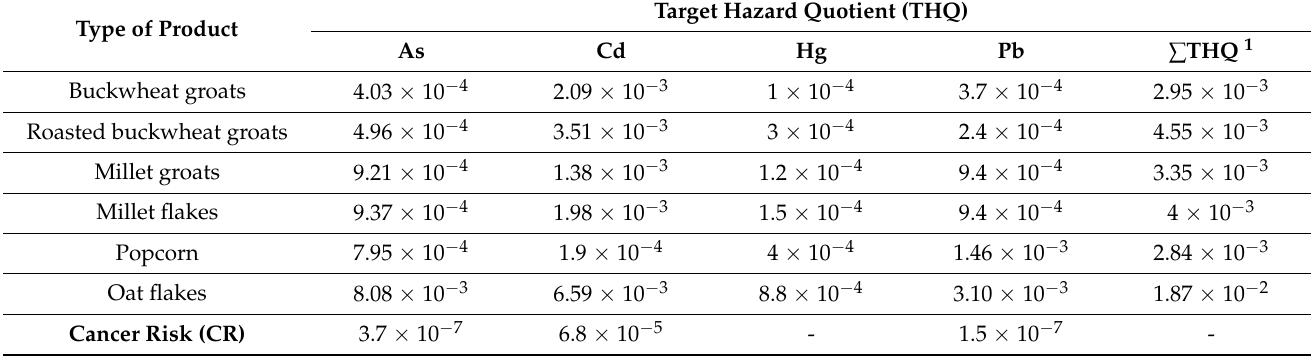
Table 6. Health risk